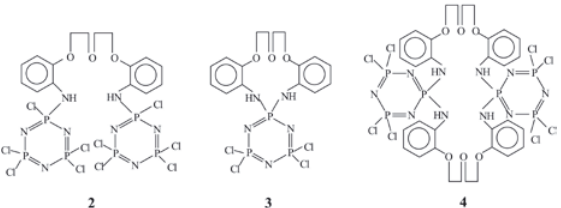
Figure 2. Structure of products 2, 3 and